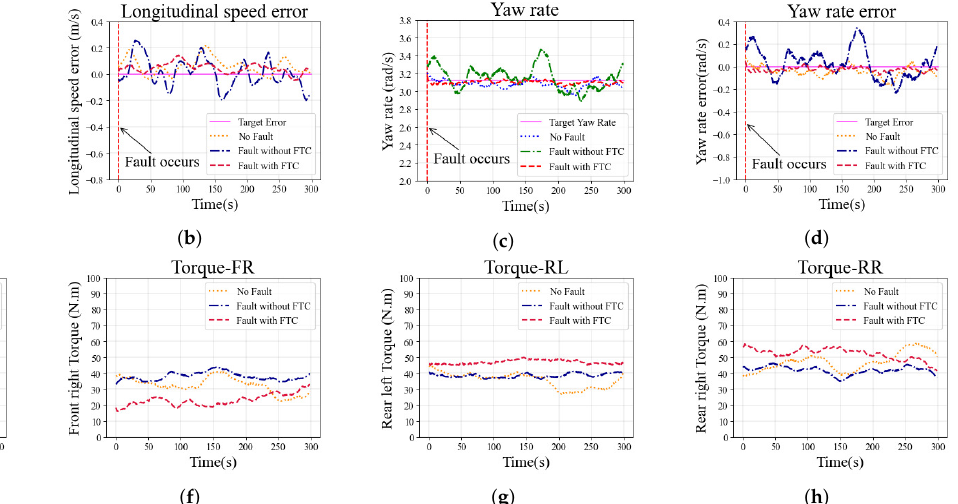
Figure 9. Simulation results in the constant steering scenario with fault F ∗ on the front left wheel: 1 ( a ) Longitudinal speed; ( b ) Longitudinal speed error; ( c ) Yaw rate; ( d ) Yaw rate error; ( e – h ) Torque on each wheel (front left, front right, rear left, and rear right). The same trend is observed in the case with fault F ∗ in the constant steering scenario, 2 as shown in Figure 10. The longitudinal speed and yaw rate fluctuations in the case without FTC are more severe than in the other two cases, and the tracking error performance is worse as well. Compared with the no-fault case, the longitudinal speed and yaw rate tracking performance of the case with FTC is similar or even better. Driving wheel torques with fault F ∗ in the constant steering scenario are shown in Figure 10e–h. The torque on 2 the rear right wheel with fault F ∗ is significantly increased due to additive fault, and the 2 front right torque is reduced to balance the yaw of the vehicle.